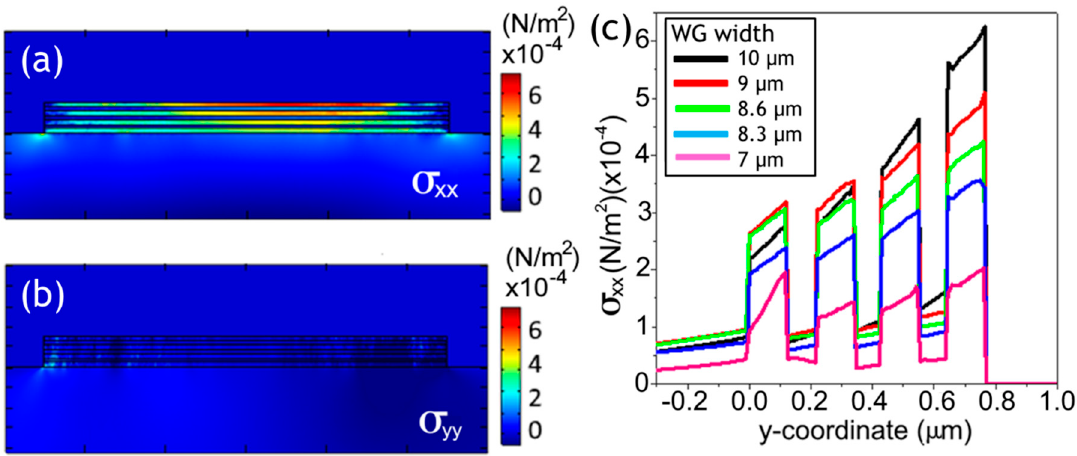
Figure 10. Stress calculations in a SiN multilayer WG with a width of 10 µm: ( a ) component σ xx and ( b ) component σ yy . Stress profile: ( c ) component σ xx along the y-coordinate in x = 0.